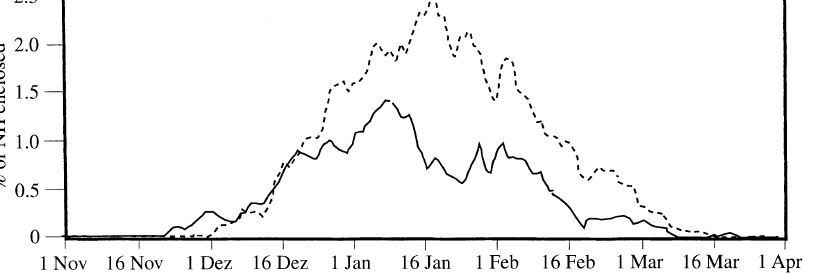
Fig. 5. Solid line : time-series of the fractional area of the northern hemisphere at 50 hPa (in percent) in the model, which is covered by type-I PSC, as calculated by means of the 11- year model simulation. Dashed line : time- series of the fractional area of the northern hemisphere at 50 hPa (in percent) with tem- perature values below 195 K, as determined by observed temperatures over an 18-year period [reproduced from Pawson et al . (1995)]